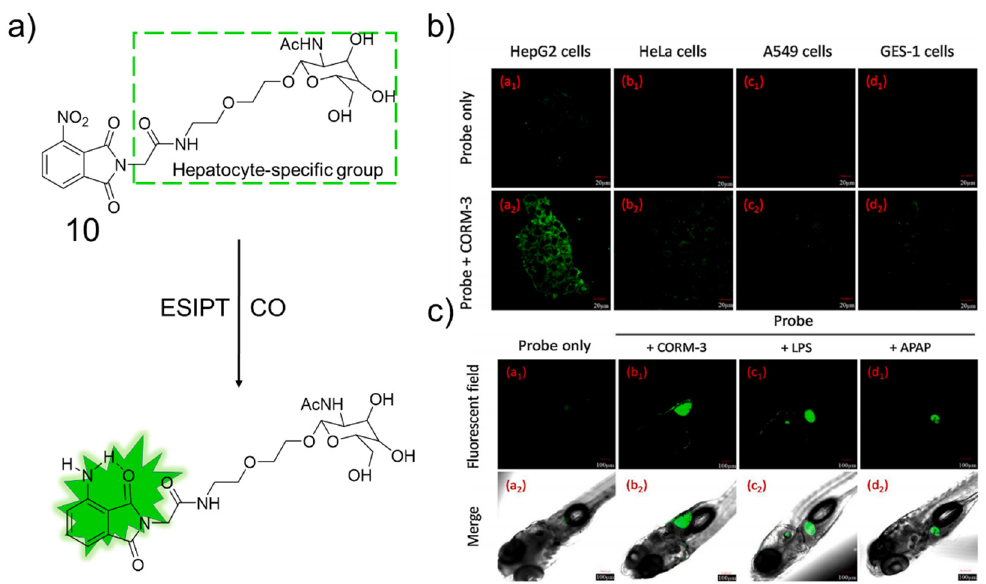
Figure 7. ( a ). The chemical structure of probe 10 and the response mechanism towards CO. ( b , c ). The fluorescence imaging of 10 to detect exogenous CO in different cells and zebrafish. Copyright (2021) Elsevier Ltd. [27].